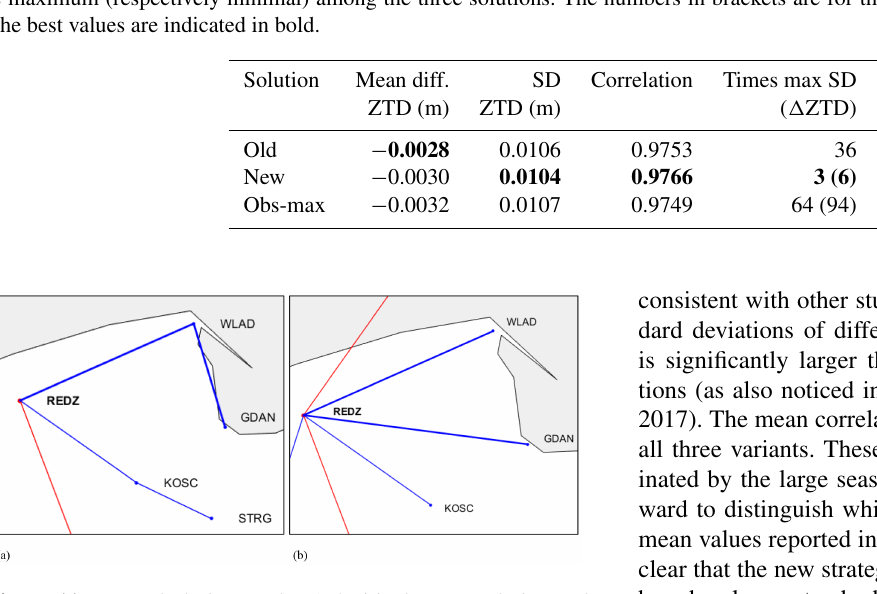
Figure 11. Network design on day 170: (a) obs-max solution and (b) new